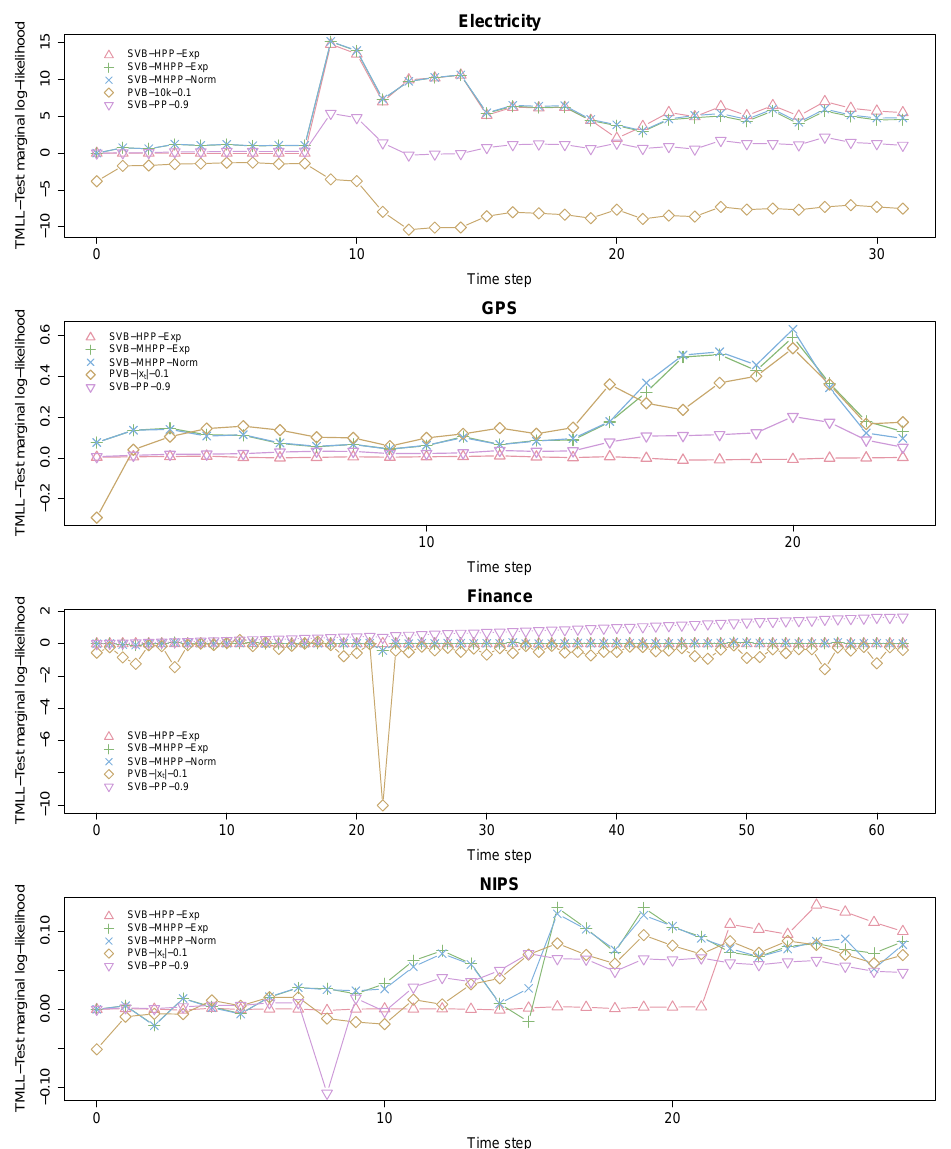
Figure 7. Results of the TMLL t improvement over SVB for the competing methods for the four real data